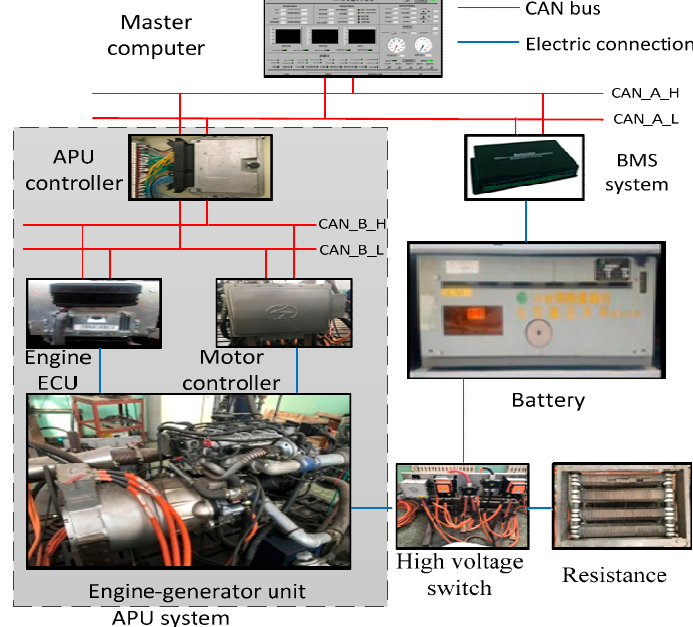
Figure 12. APU test bench structure.